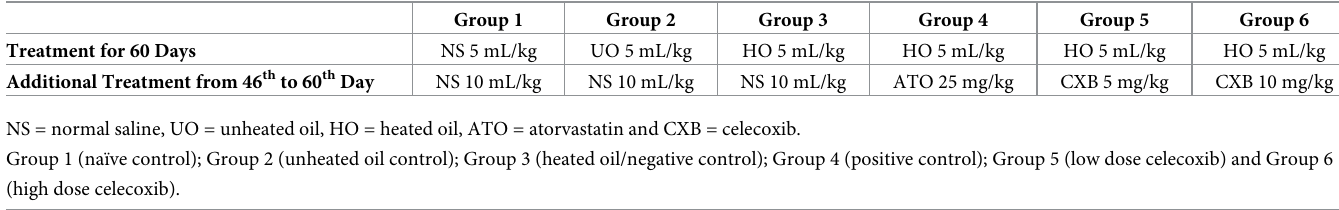
Table 1. Treatment